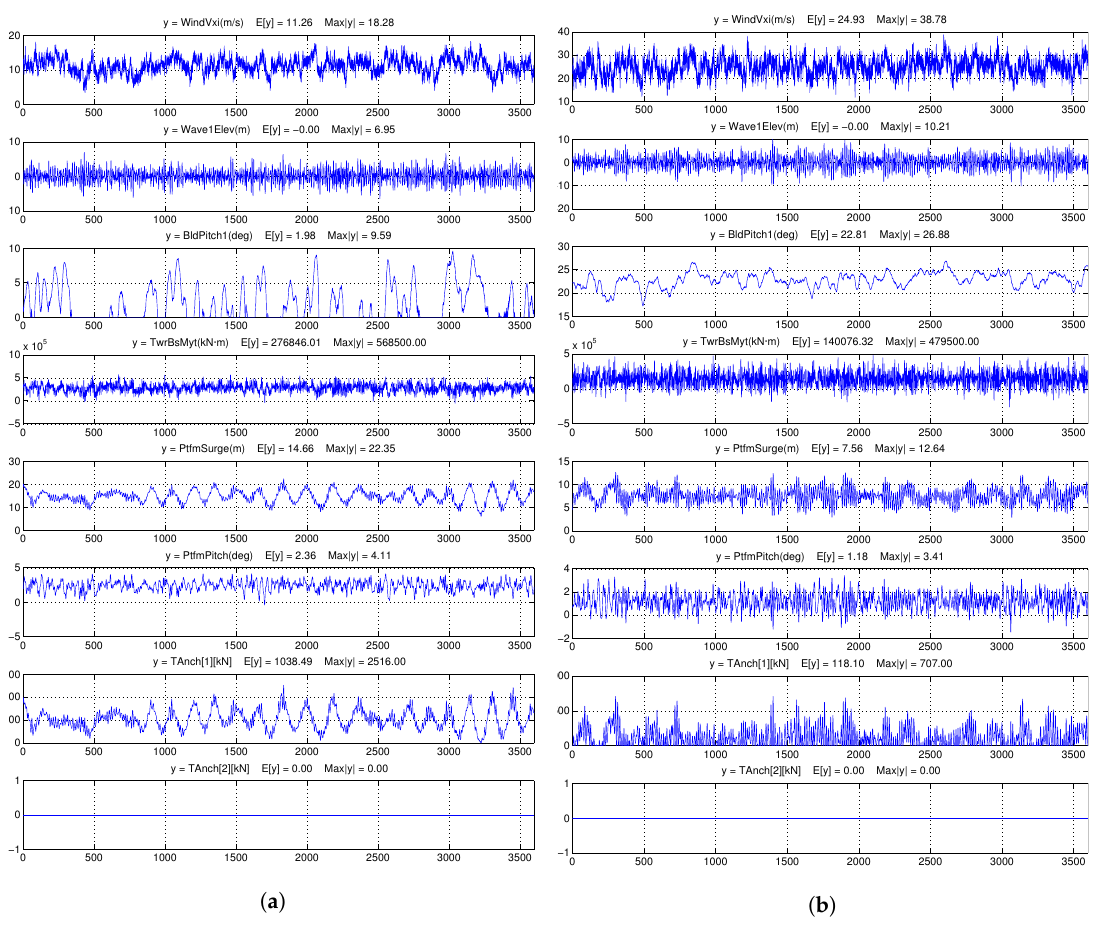
Figure 15. One-hour time series of the SNL 13.2-MW turbine-platform integrated system under different sea states: ( a ) V hub = 11.3 m/s, H s = 7.77 m, T p = 14.43 s; ( b ) V hub = 25.0 m/s, H s = 11.52 m, T p = 14.31